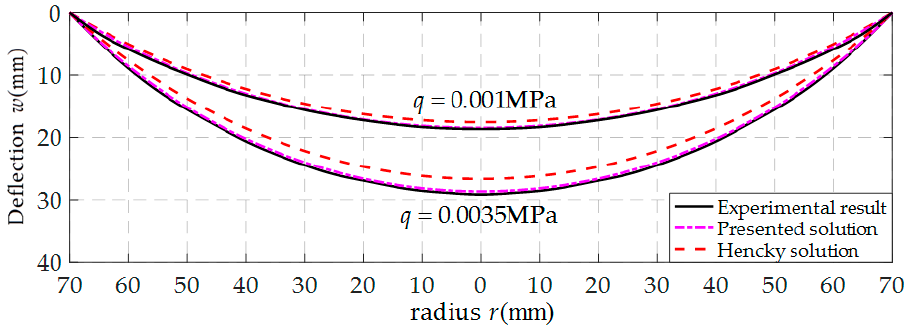
Figure 8. Variation of w with r .